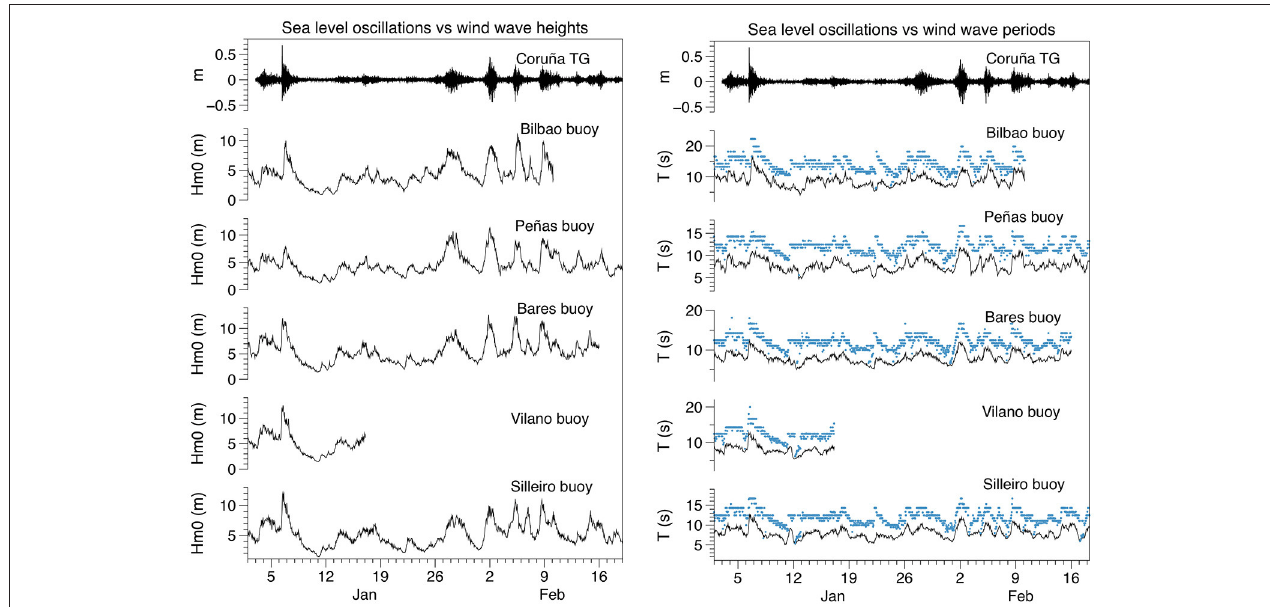
FIGURE 3 | Significant wave height H m0 (left) and periods ( right: mean period T m , black line, peak period T p , blue dots) recorded in open waters by the PdE deep water buoys during the stormy period of January and February 2014. Sampling interval from the buoys is 1h. Sea level oscillations (1min high-pass filtered sea level) from Coruña tide gauge at the top of both plots for comparison: the larger oscillations occur during the extreme events of wind